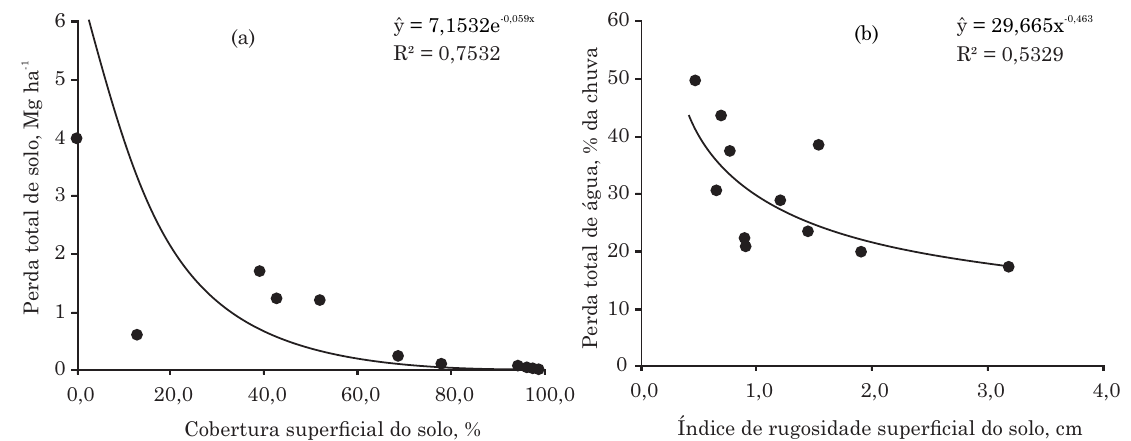
Figura 4. Relação da cobertura superficial do solo com sua perda total por erosão (a) e do seu de índice de rugosidade superficial com a perda total de água (b), nos tratamentos